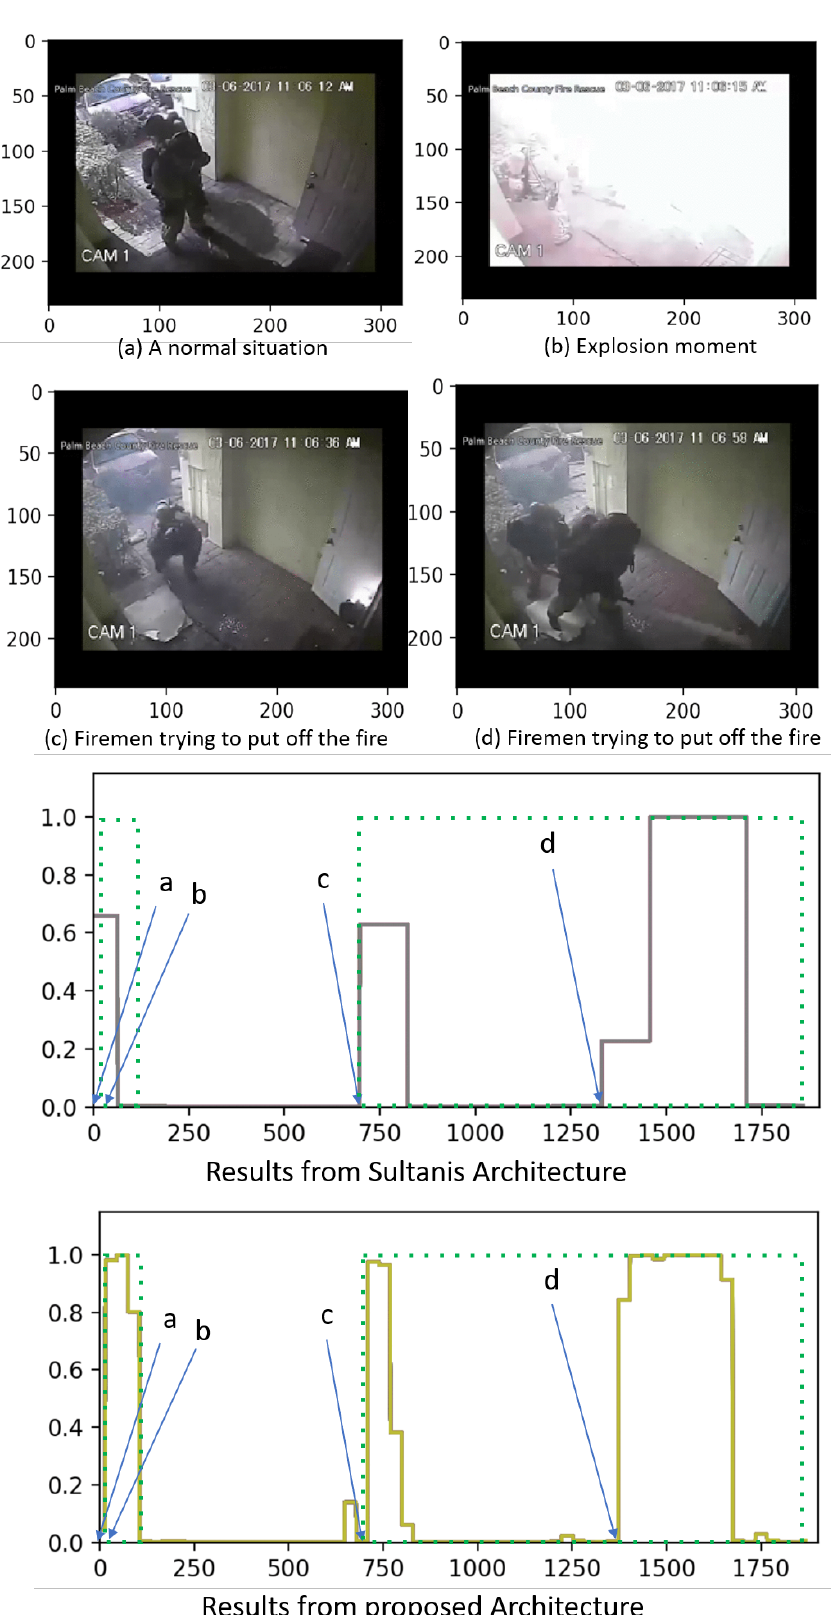
Figure 7. Qualitative visual results and comparison in scenes from